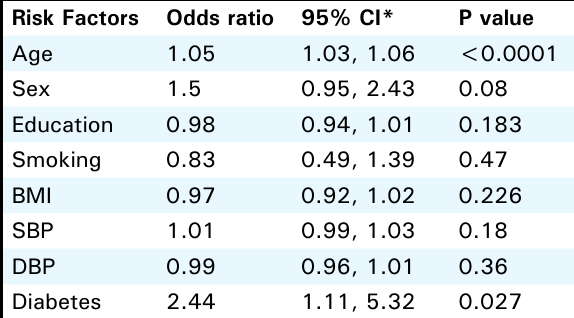
Figure 1. Majority of them had 1 + proteinuria. Dipstick positive protein ≥3 + was recorded in 0.6% of the screened asymptomatic population. There is a trend for higher prevalence of proteinuria in underweight (6.0%) than in the overweight (5%) and obese (4%) subjects. Proteinuria was found in 7.9% of hypertensive population but only 3.3% in normotensive subjects. 14.5% diabetics were proteinuric as compared to 4.2% of non-diabetics. There was linear relationship between age and proteinuria with prevalence of proteinuria 5 times higher in subjects ≥60 years than in young people (≥20 - 39 years). Together proteinuria and diabetes were observed in 1.1% (n=35) of the screened population, whereas 0.8% (n=27) of subjects had combination of proteinuria, hypertension and diabetes.